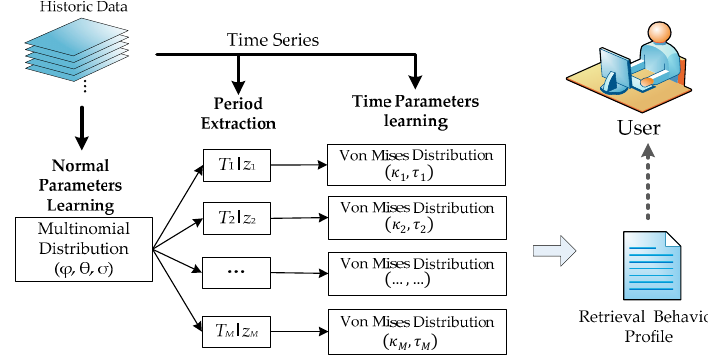
Figure 6. Inference and modeling process of STPT.